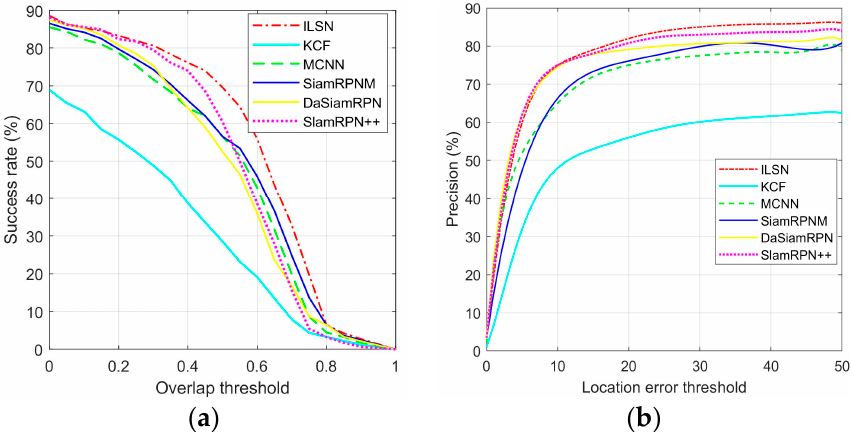
Figure 5. The success rate and tracking precision of each algorithm on the UAV dataset. ( a ) Success rate; ( b )